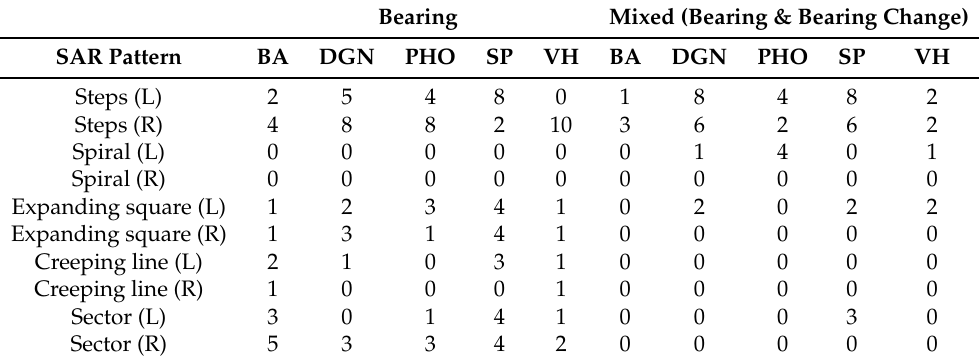
Table 5. Number of trajectory segments where SAR patterns have been detected, using bearing only and bearing together with bearing change (mixed).